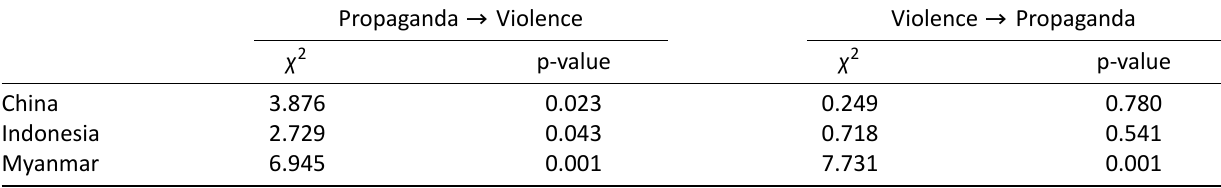
Table 1. Summary of Granger causality test results between propaganda and violence. Propaganda →